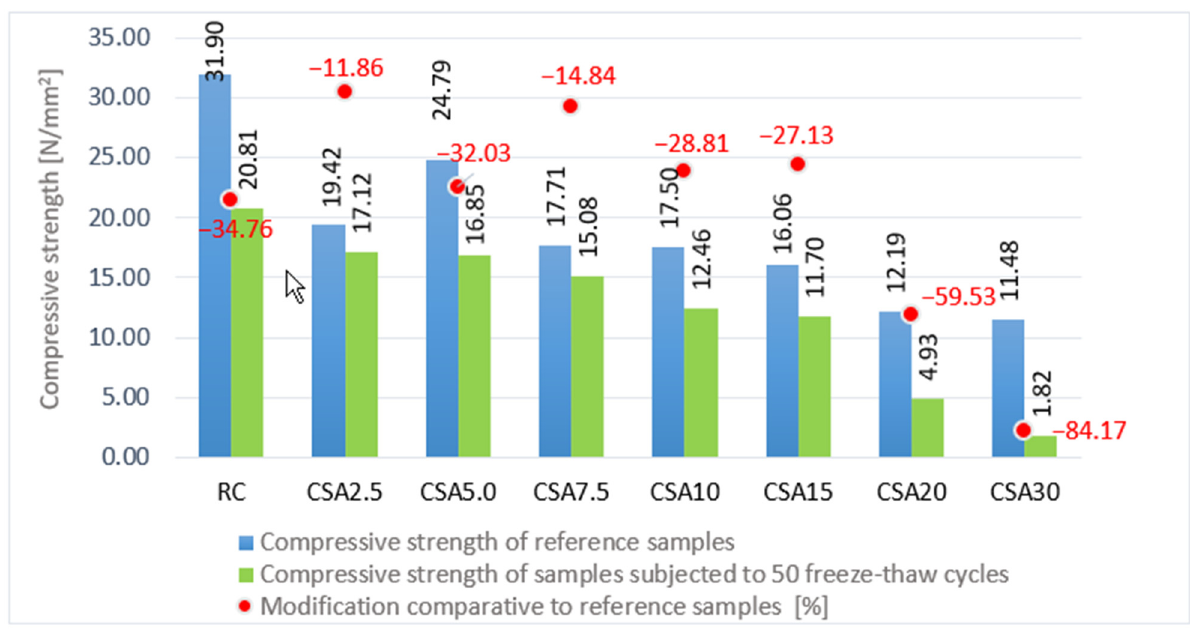
Figure 13. Variation in the compressive strength of the samples after testing for 50 freeze–thaw cycles, comparative to the non-frozen samples (%).